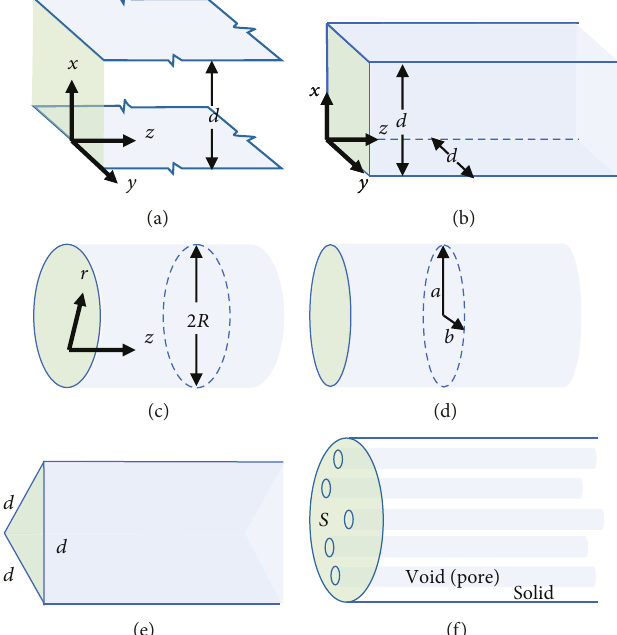
Figure 2: Void spaces (a) between parallel planes and in straight tubes of (b) a square cross section; (c) a circular cross section; (d) an elliptic cross section; and (e) an equilateral triangular cross section. (f) An ideal porous medium sample consisting of solid and many straight pores. The green area indicates the outer